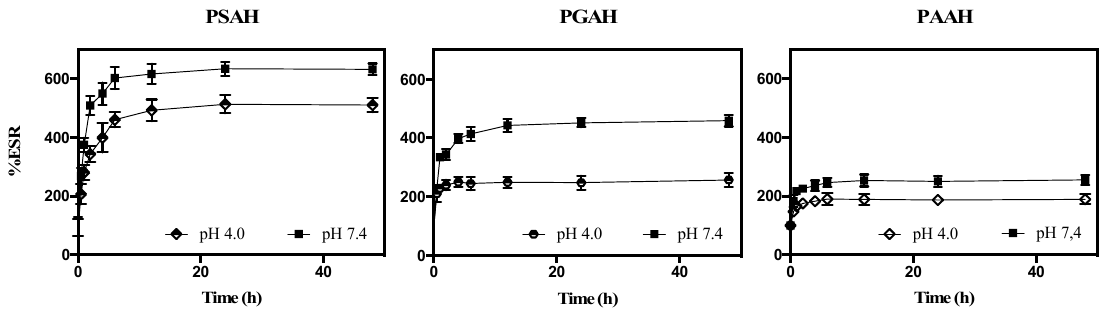
Figure 2. The swelling ratio of the hydrogels at 24–25 °C as a function of time, pH, and crosslinker nature. Data are shown as mean ± SD ( n = 3).